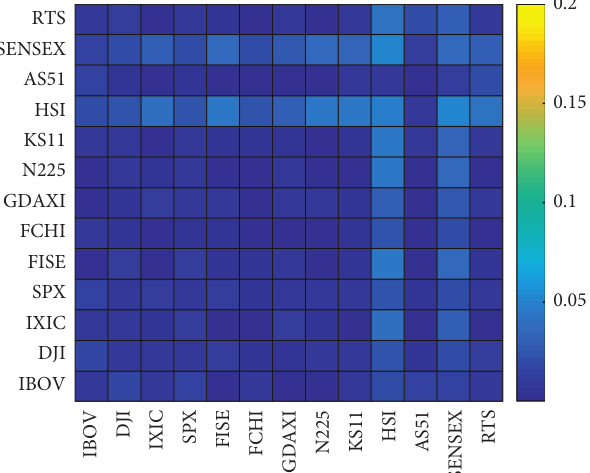
between SSEC and HSI. 2